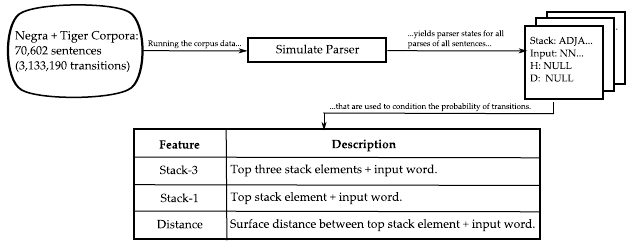
Figure 1 . Estimating the parser’s probability model.